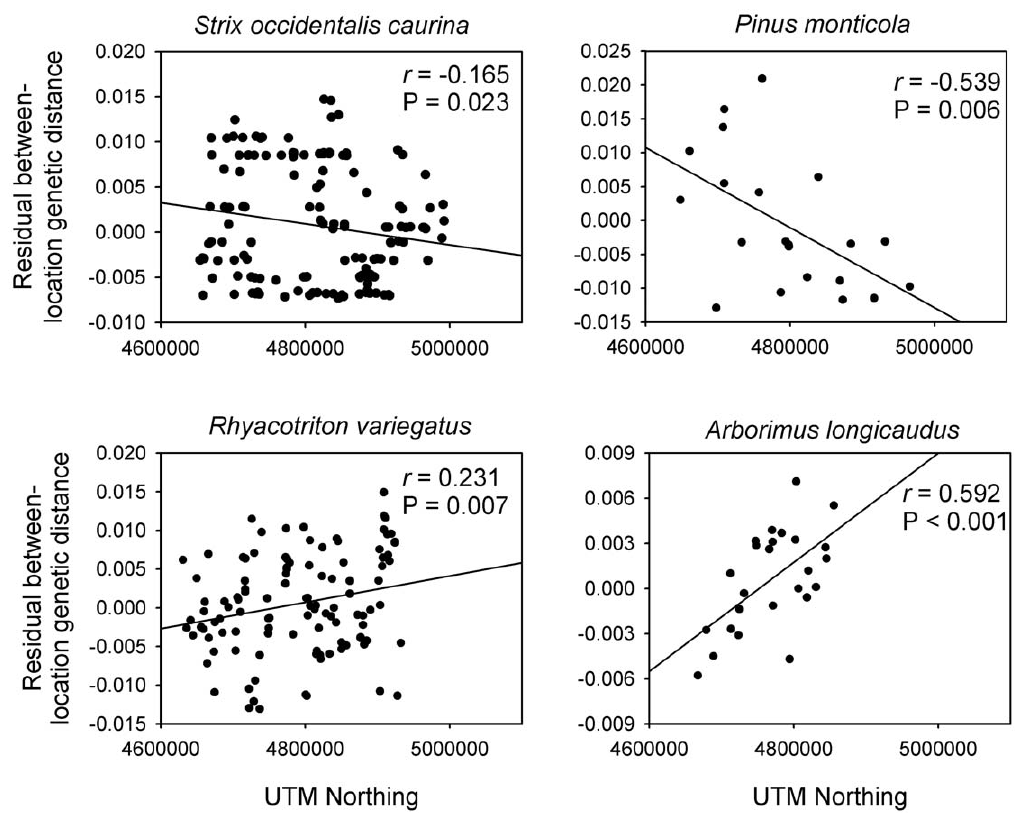
Figure 4. Results of regression/correlation analyses designed to confirm patterns observed in Genetic Landscape Shape analyses (Fig. 3). Analyses of S. occidentalis caurina and P. monticola show significant negative correlations between genetic distance patterns and UTM northing coordinates. In contrast, R. variegatus and A. longicaudus both show positive correlations between genetic distance patterns and UTM northing coordinates.